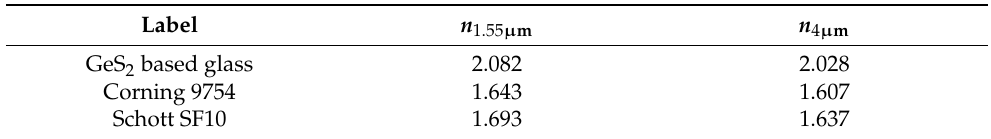
Table 1. Label and refractive index of the samples. The data for the 9754 and the SF10 come from the Corning and Schott datasheets, respectively. For GeS 2 data were measured using refractometry in total internal reflection